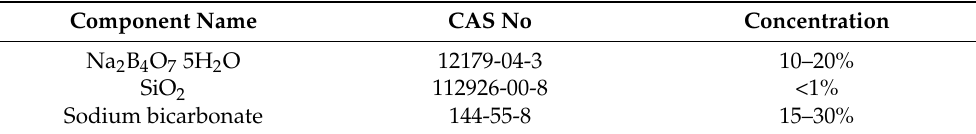
Table 3. Component properties of boron-based liquid fire suppressant [19].